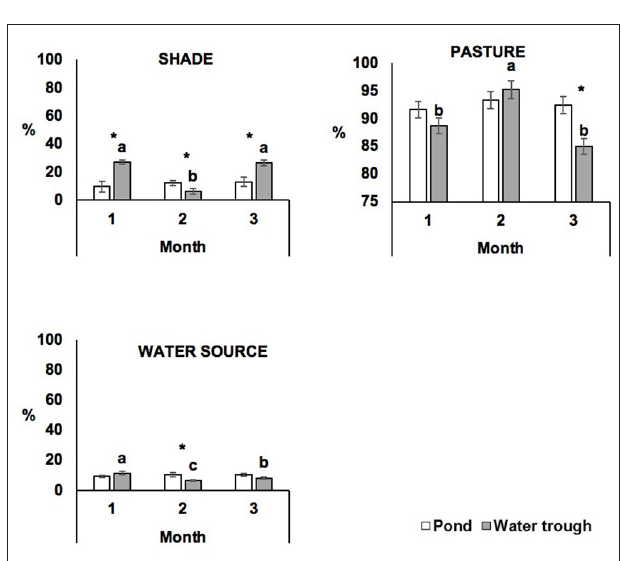
FIGURE 3 | Effect of treatment and period on steer distribution (least square means ± s.e.m.) on the paddock. Shade, grassland, and water source are expressed in least square means ± s.e.m. of the percentage of animals positioned on the three periods of observation. Different letters “a, b, c” represent significant differences ( P ≤ 0.05) between periods of observation within treatment. “*” represents significant differences ( P ≤ 0.05) between treatments within the period of